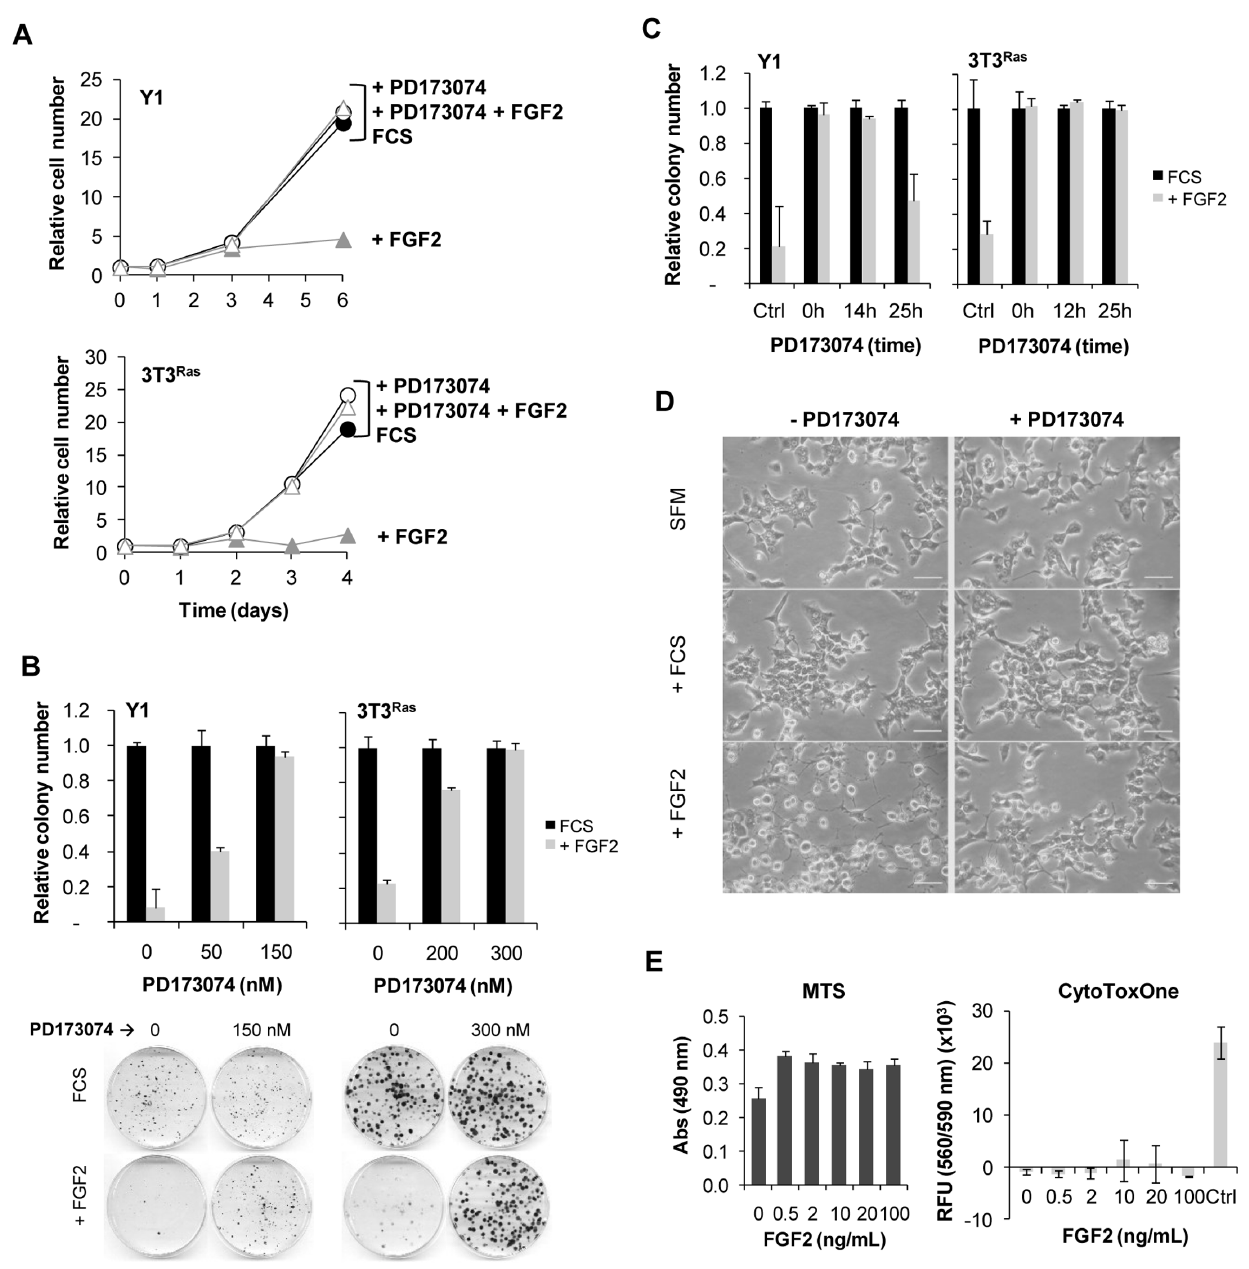
Figure 1. FGF2-induced cell growth inhibition of Y1 and 3T3 Ras cells is dependent on FGF receptor activation. ( A ) Growth curves with FGF2 (10 ng/mL) and PD173074 (150 nM for Y1 and or 300 nM for 3T3 Ras cells) added 5 minutes before FGF2 (10 4 cells/cm 2 were plated). ( B ) Clonogenic assays of Y1 and 3T3 Ras cells treated with FGF2 and/or PD173074 (added 5 minutes before FGF2) for 24 hours. Inset below shows one representative clonogenic assay. ( C ) Clonogenic assays of Y1 and 3T3 Ras cells in the presence of FGF2, added at time 0, and PD173074, added after FGF2 at the indicated times. ( D ) Microphotographs for morphological analysis of Y1 cells treated with FCS (10%) or FGF2 (10 ng/mL) for 48 hours in the presence, where indicated, of PD173074 (150 nM). Scale bar=50 m m. ( E ) MTS Assay (CellTiter 96 H AQueous) and CytoTox-One TM Assay (membrane integrity) performed with increasing concentrations of FGF2. RFU, Relative Fluorescent Unit. Control refers to 100% cell lysis. Values are mean 6 s.e.m (n=2–5). FCS, fetal calf serum. this signaling system can promote mesenchymal-to-epithelial transition in tumor cells [29,30].